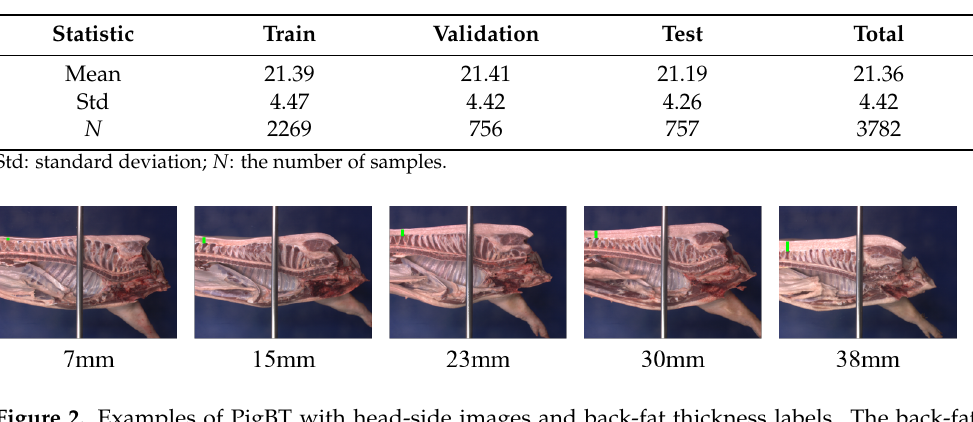
Figure 2. Examples of PigBT with head-side images and back-fat thickness labels. The back-fat thickness is marked in